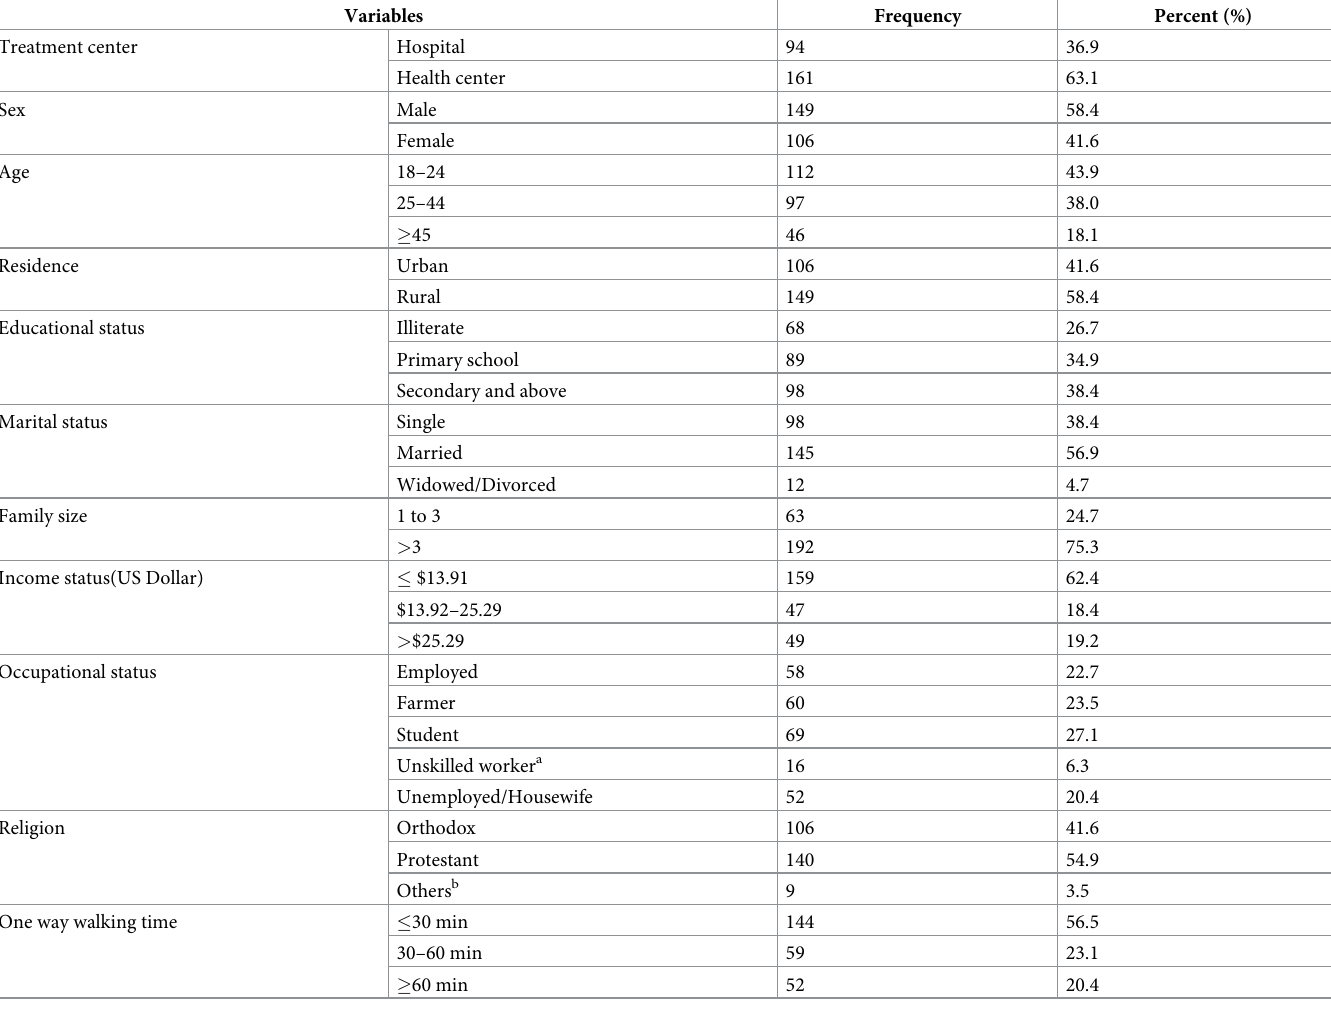
Table 1. Socio-demographic characteristics of TB patients in Gamo zone public health facilities, Southern Ethiopia, 2019 (n =